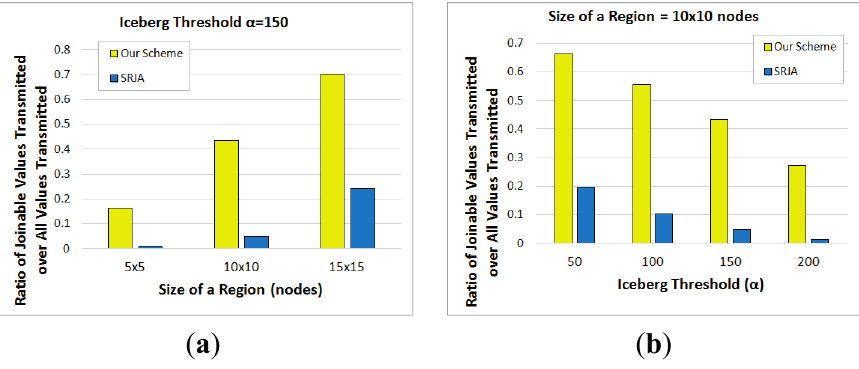
Figure 14. Comparison of the Ratio of Joinable Values Transmitted with respect to ( a ) varying sizes of a region ( α = 150 ); ( b ) varying iceberg thresholds (10 × 10